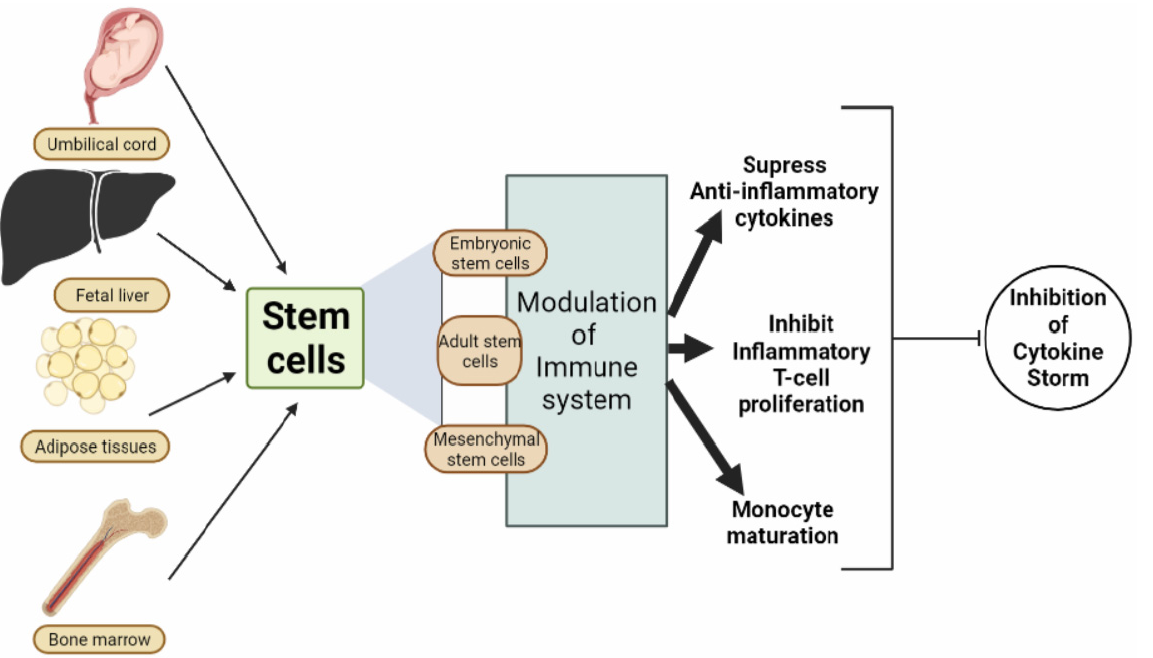
Figure 1. Modulation of immune system by different types of stems cells to prevent cytokine storm.